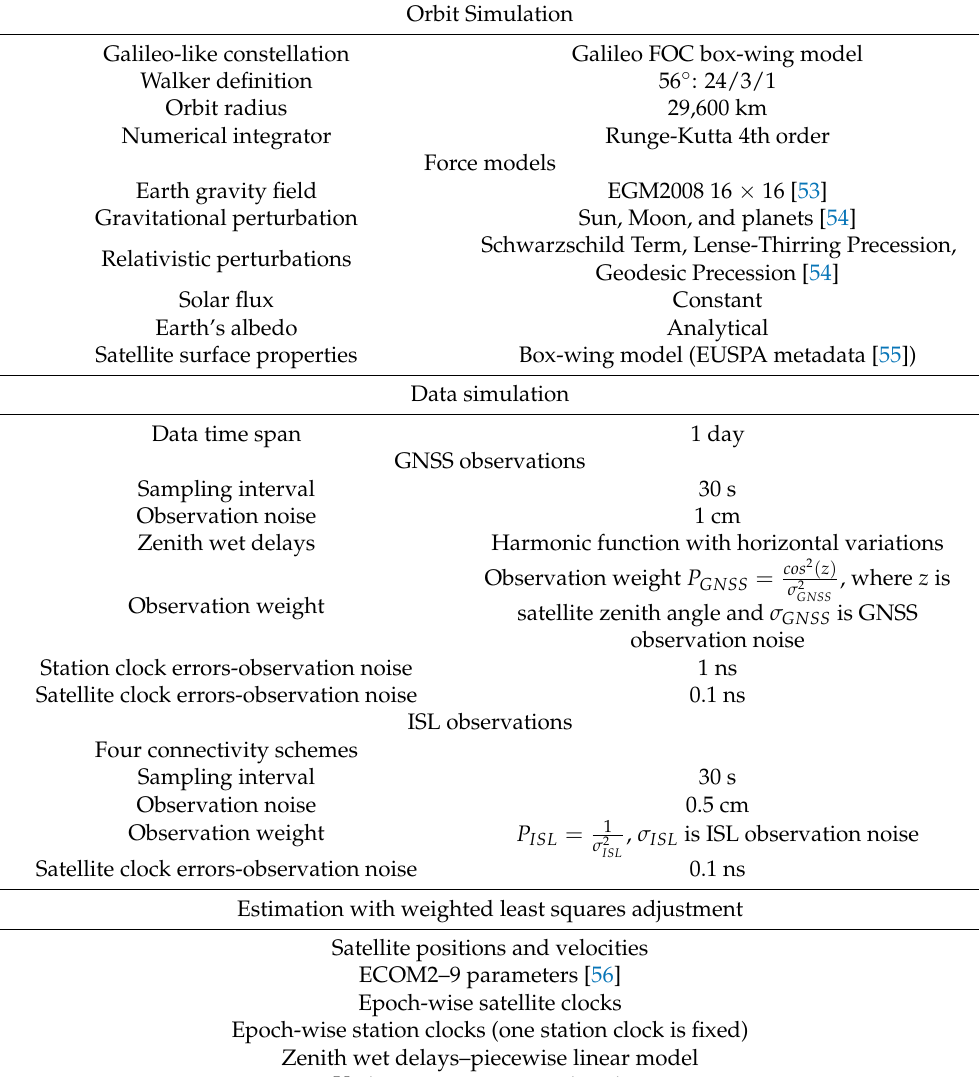
Table 1. Simulation and estimation